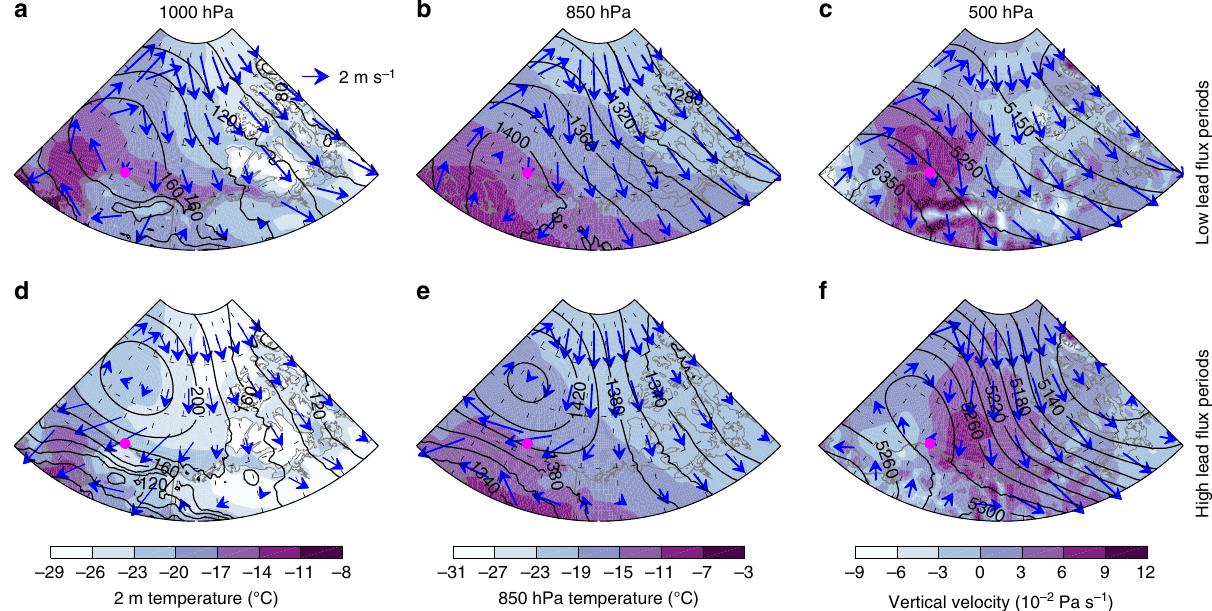
Fig. 2 Large-scale synoptic conditions. a – c Composites of geopotential height (black contours) and wind velocity (arrows) at 1000 hPa (wind is at 10 m), 850 and 500 hPa for the set of low lead fl ux periods. Color shading indicates 2-m air temperature, 850-hPa temperature, and vertical velocity, respectively. d – f The same as a – c but for the high lead fl ux periods. The domain is 65 – 85 °N, 90 – 180 °W, and the Barrow site is indicated by the fi lled magenta boundary layer clouds from the four cases (i.e., OPEN, OPEN- pro fi les (Fig. 3) illustrate the cloud evolution in each case, while OPEN, OPENFROZEN, and FROZENFROZEN, see Methods) the time series of cloud coverage (Fig. 4) further quantitatively are displayed in Figs. 3 and 4. The FROZENFROZEN case is not indicates the differences of cloud amount between these cases. shown in Fig. 3 because no radiatively signi fi cant clouds are Here a threshold of 3.0 g m − 2 is chosen in Figs. 3 and 4 as downwelling LW radiation is particularly sensitive to total water generated in this case, as shown in Fig. 4. The x – z hydrometeor